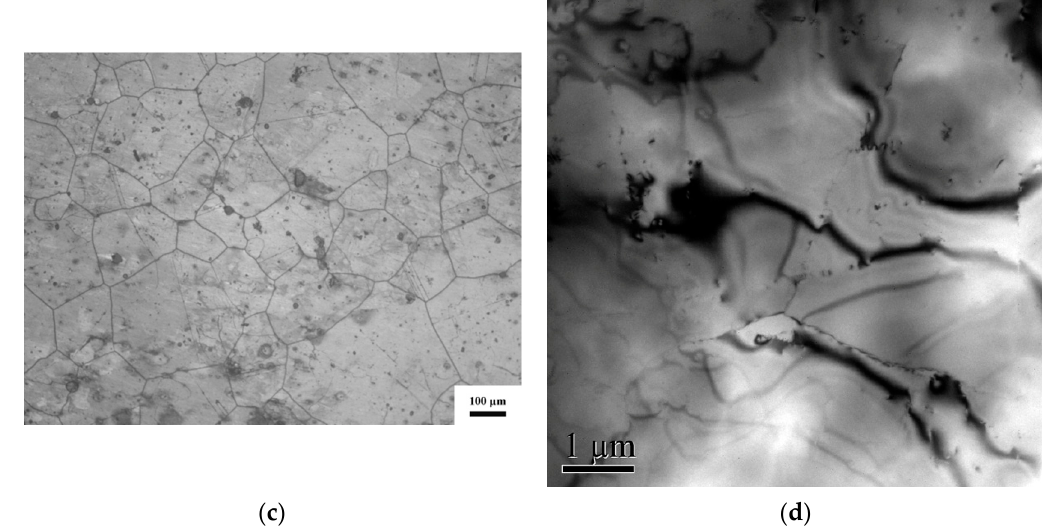
Figure 1. Initial microstructure of the NiCrFeCoMn HEA. ( a–c ) Optical micrographs for the as-cast sample and the alloy after homogenization heat treatment and the deformed alloy, respectively. ( d ) Bright field electron image for the deformed NiCrFeCoMn high-entropy alloy.